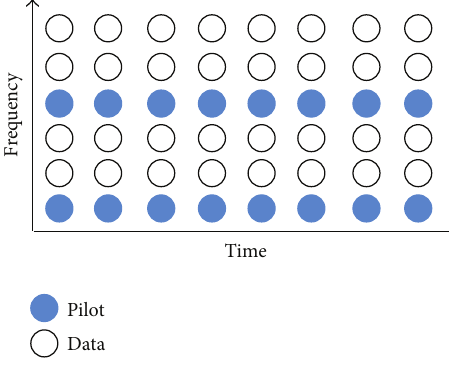
Figure 3: Comb-type pilot arrangement.